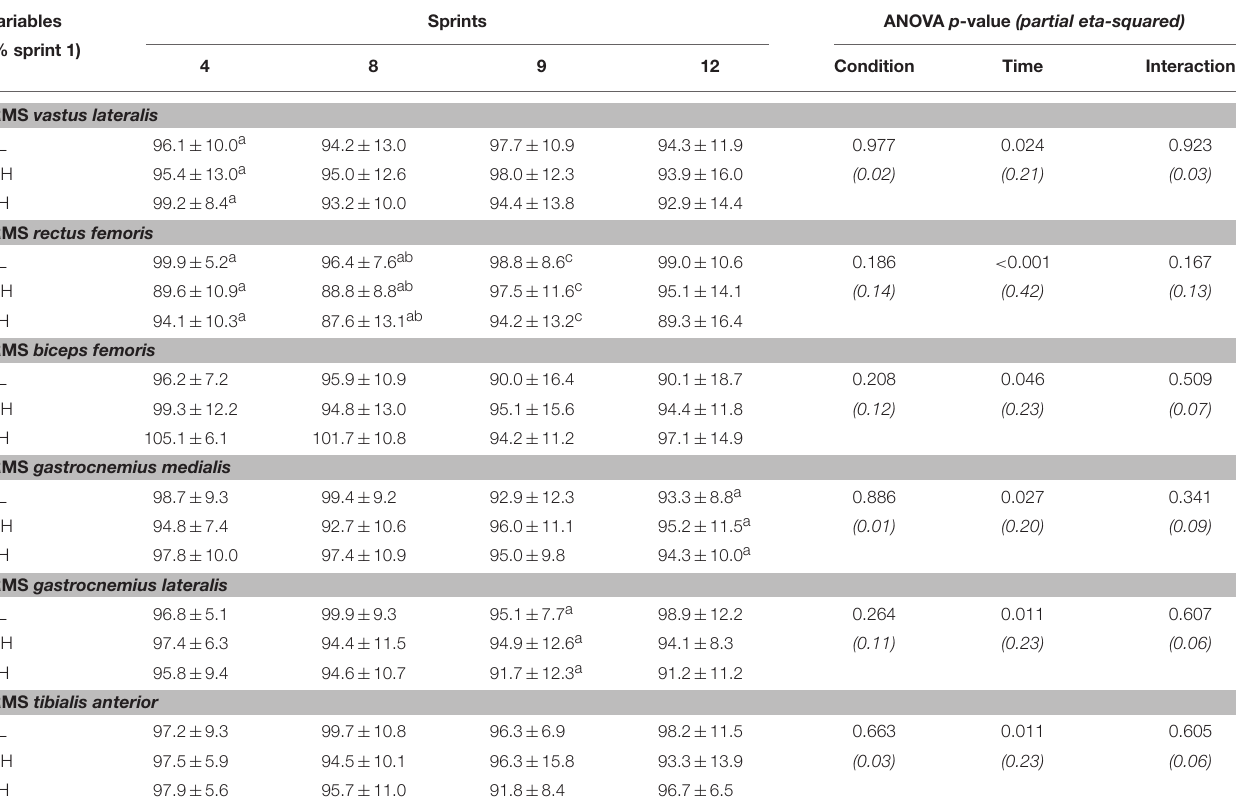
TABLE 3 | Surface EMG median power frequency (MPF).